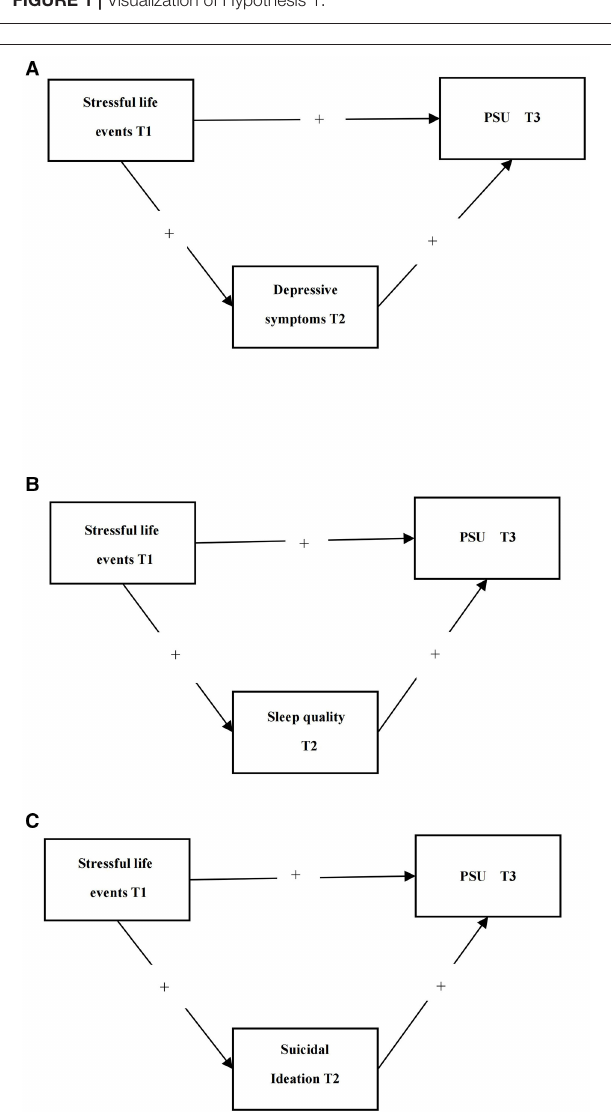
FIGURE 2 | Visualization of Hypothesis 2: (A) Hypothesis 2a; (B) Hypothesis 2b; and (C) Hypothesis 2c.